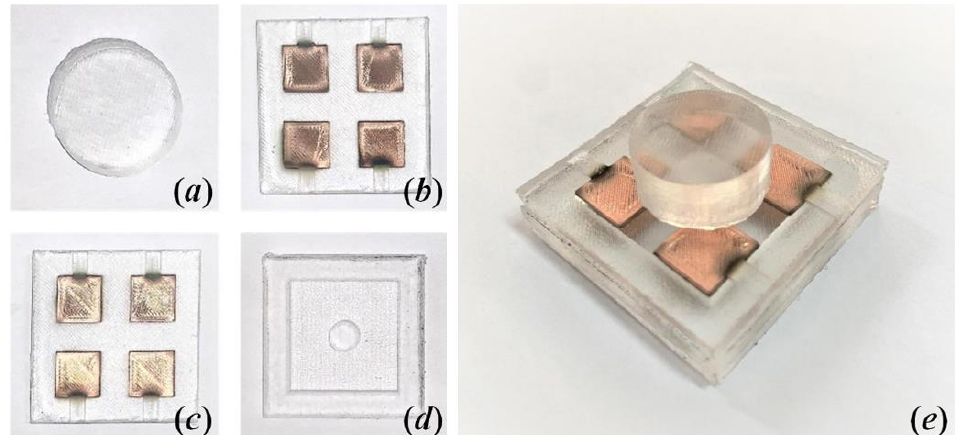
Figure 7. Photographs of ( a ) the windward pillar, ( b ) the upper electrode layer, ( c ) the support layer, ( d ) the lower electrode layer, and ( e ) the fabricated wind sensor.